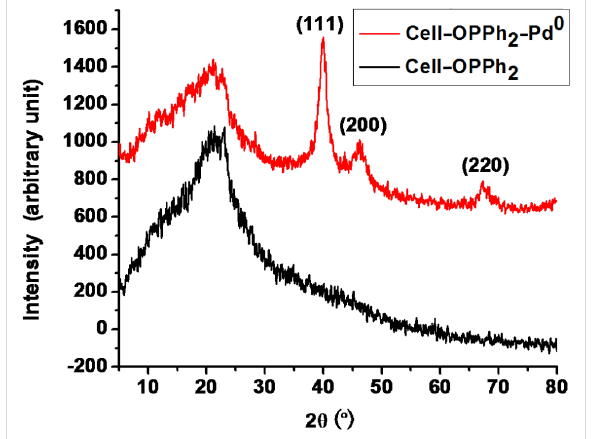
Figure 1: XRD pattern of the cellulose-supported palladium catalyst and Cell–OPPh 2 matrix.